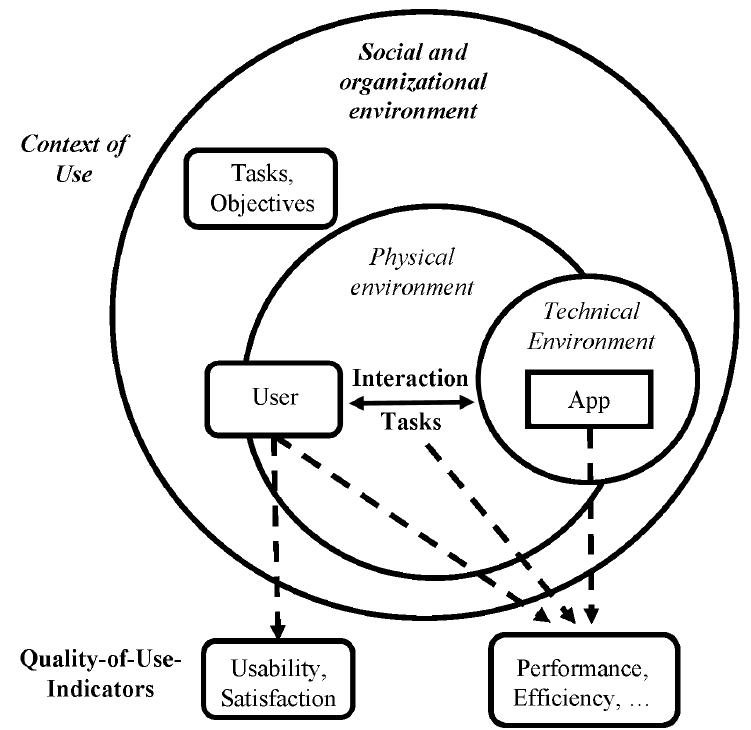
Figure 8. Usability as Quality of Use in a Context (Source: [54,55]; own depiction).